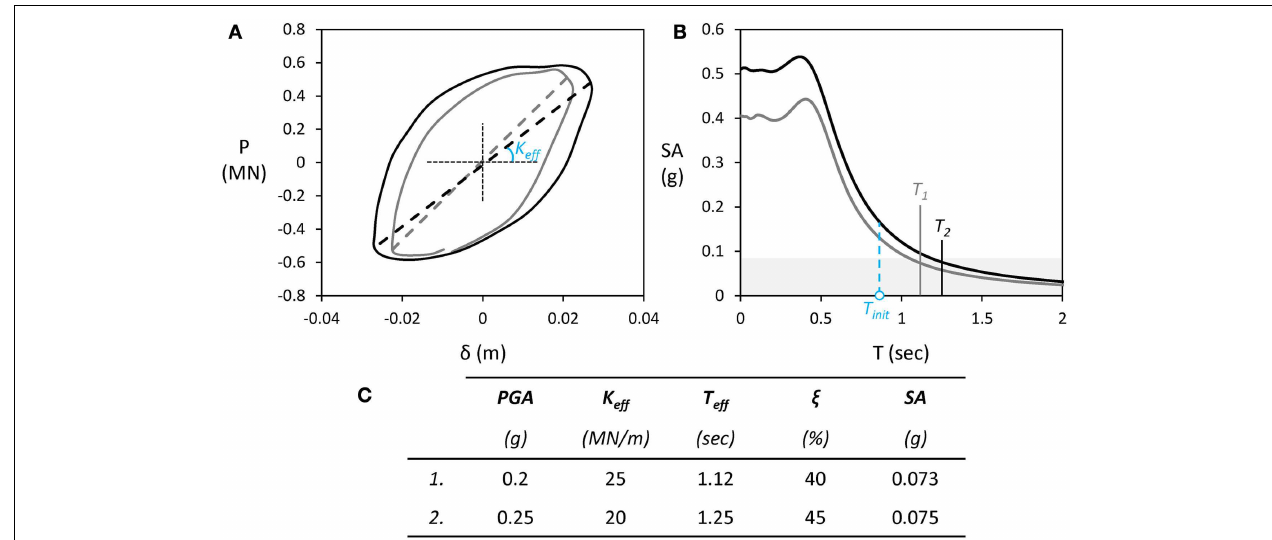
illustrative example, focusing on two excitations with PGA = 0.2 and 0.25g: (A) force–displacement ( P– δ ) response; (B) expected spectral acceleration SA as a function of effective period T; and (C)